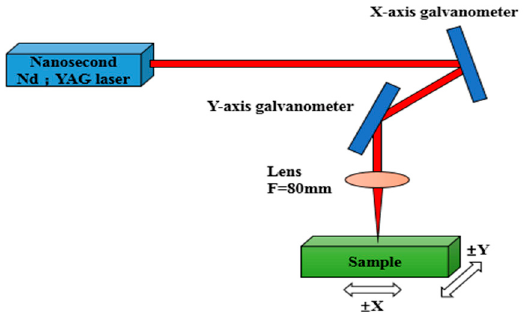
Figure 1. The nanosecond laser surface texturing system.